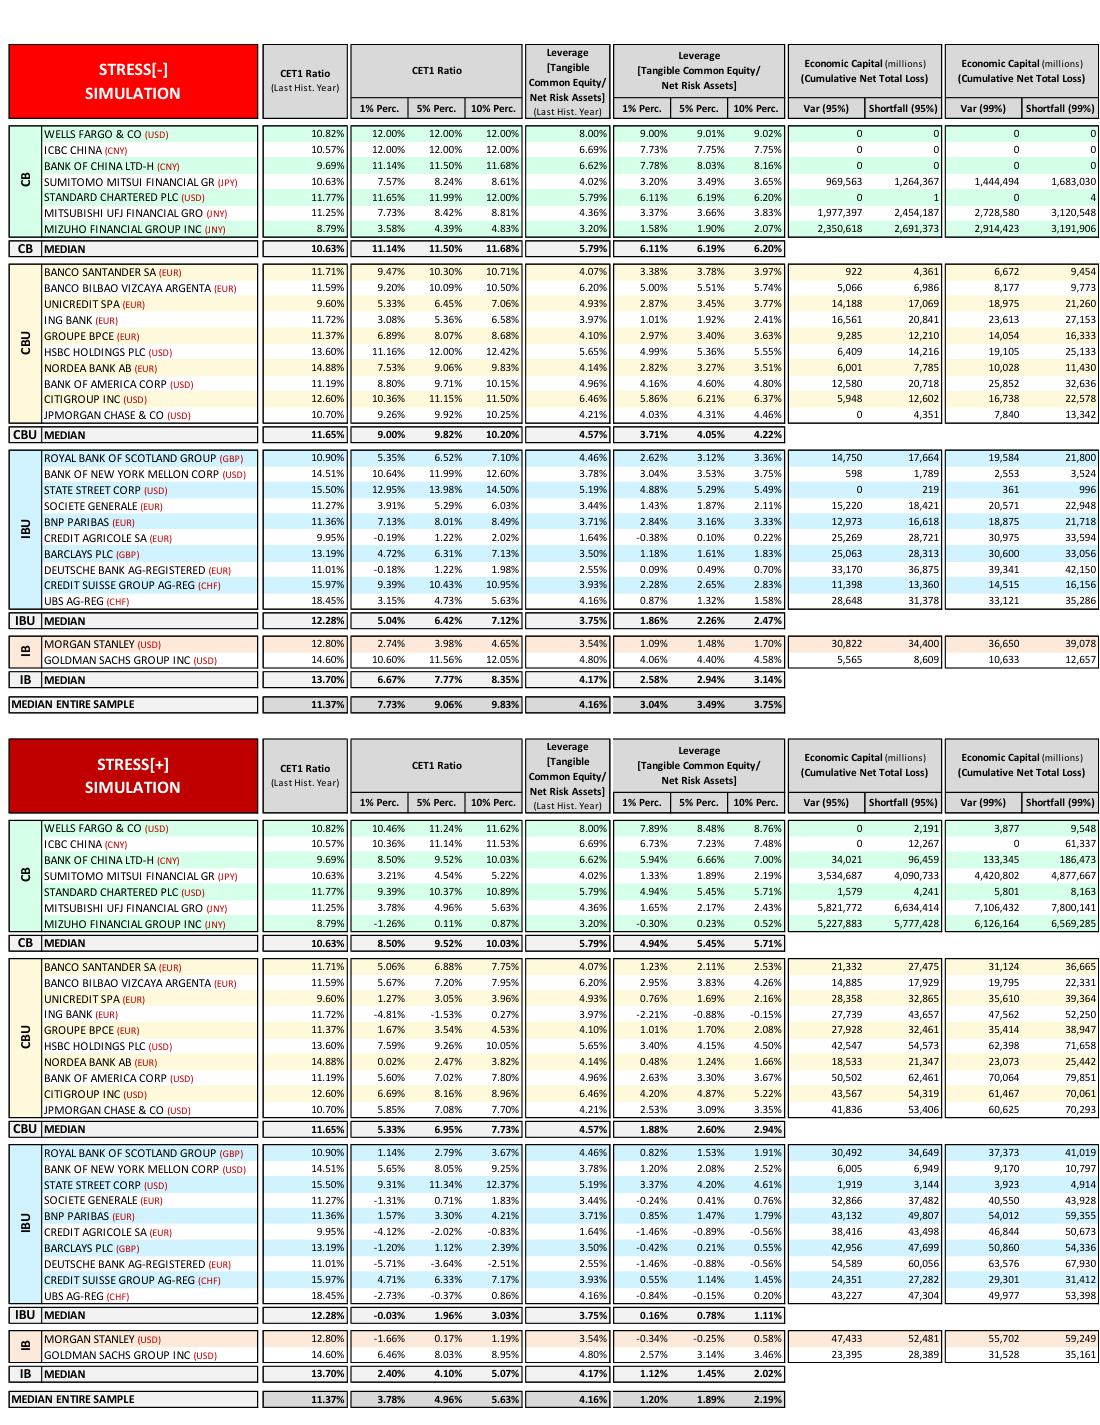
Figure A9. 2016 Stress test exercise: capital adequacy and economic capital.